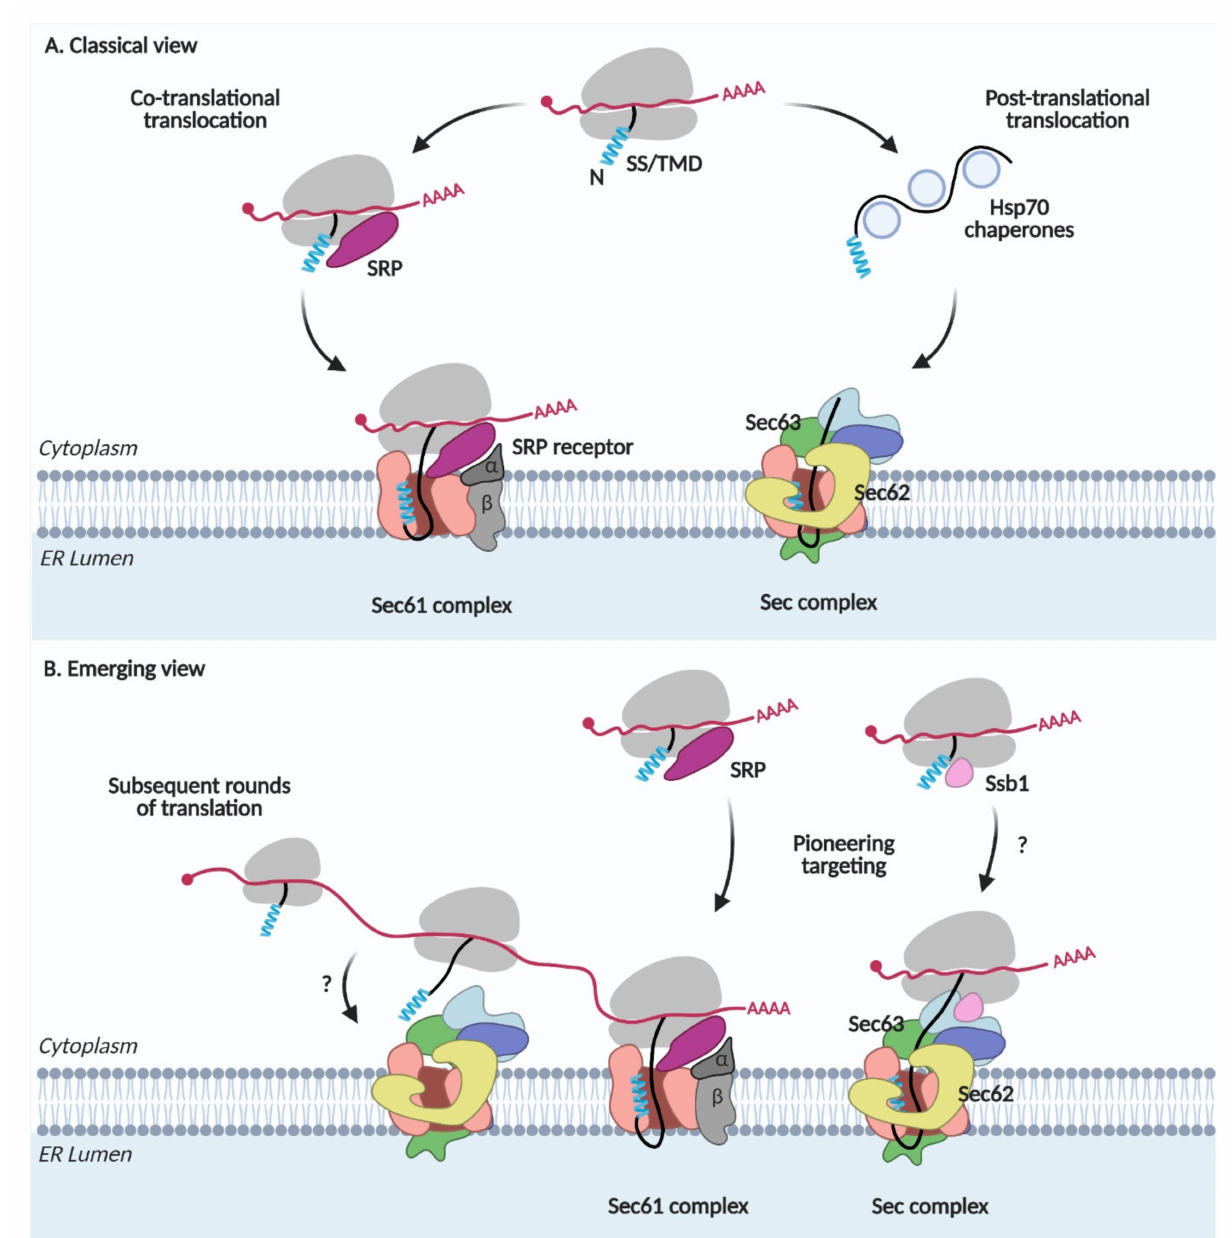
Figure 1. Protein targeting and translocation in the ER. ( A ) Classical view. SRP, signal recognition particle; SS, signal sequence; TMD, transmembrane domain. ( B ) Emerging